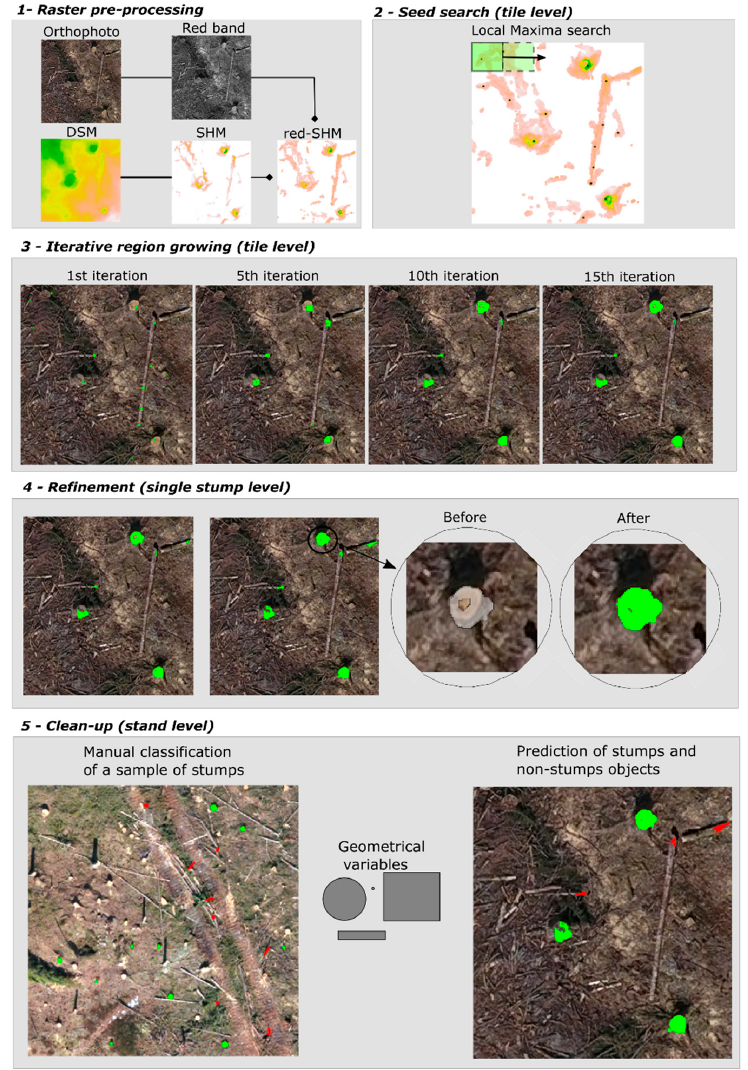
Figure 5. Schematic representation of the step adopted in the proposed algorithm for tree-stump detection and segmentation. The example is provided for one of the 100 m 2 tiles that were initially clipped. Throughout steps 1 to 4, the green polygons represent potential tree-stumps while in step 5 they represent the final detected tree-stumps, while the red polygons represent non-tree-stump objects. A detailed description of the different steps is provided in Section 3.1.